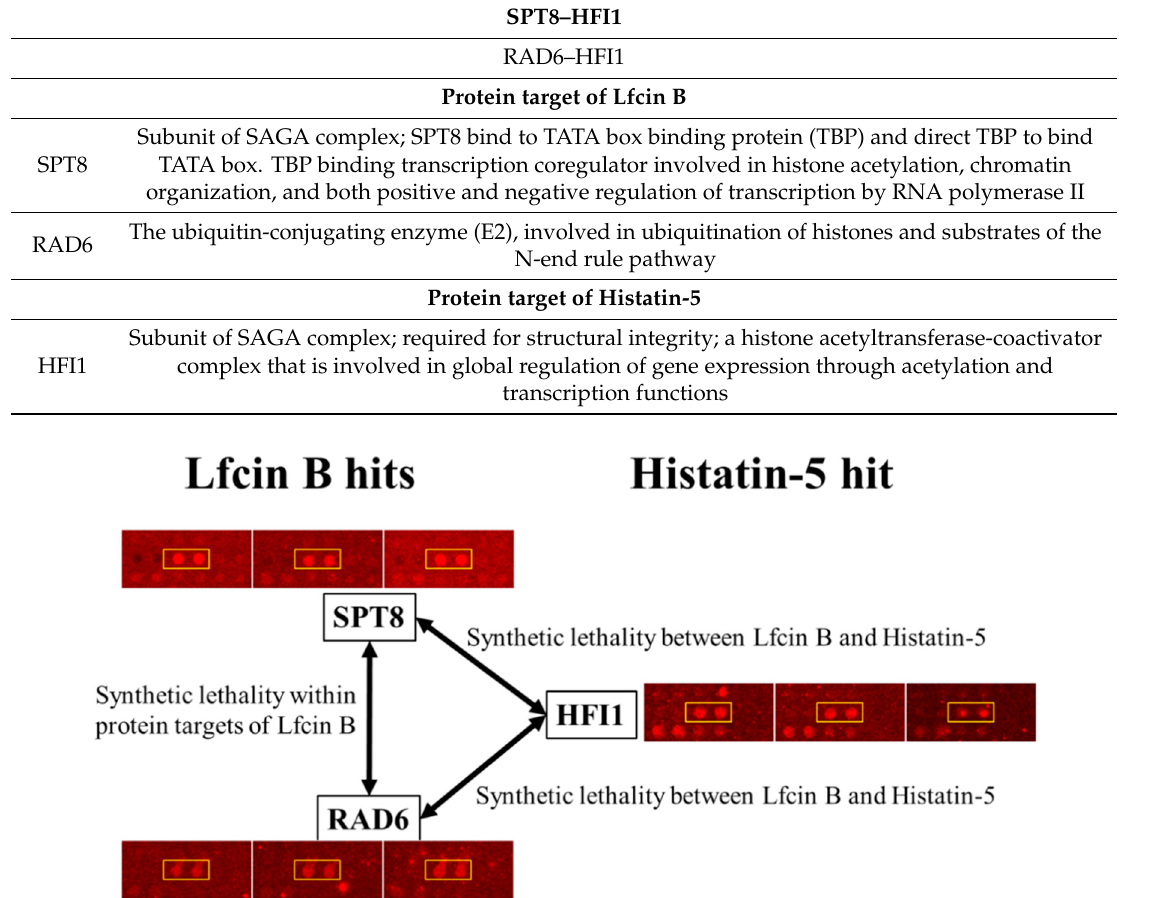
Figure 7. Synthetic lethality and enlarge protein images of SPT8, RAD6, and HFI1 on yeast proteome microarray. The enlarged protein images of two synthetic lethality pairs identified between the unique hits of Lfcin B and Histatin-5 as well as the synthetic lethality pair within the protein targets of Lfcin B.